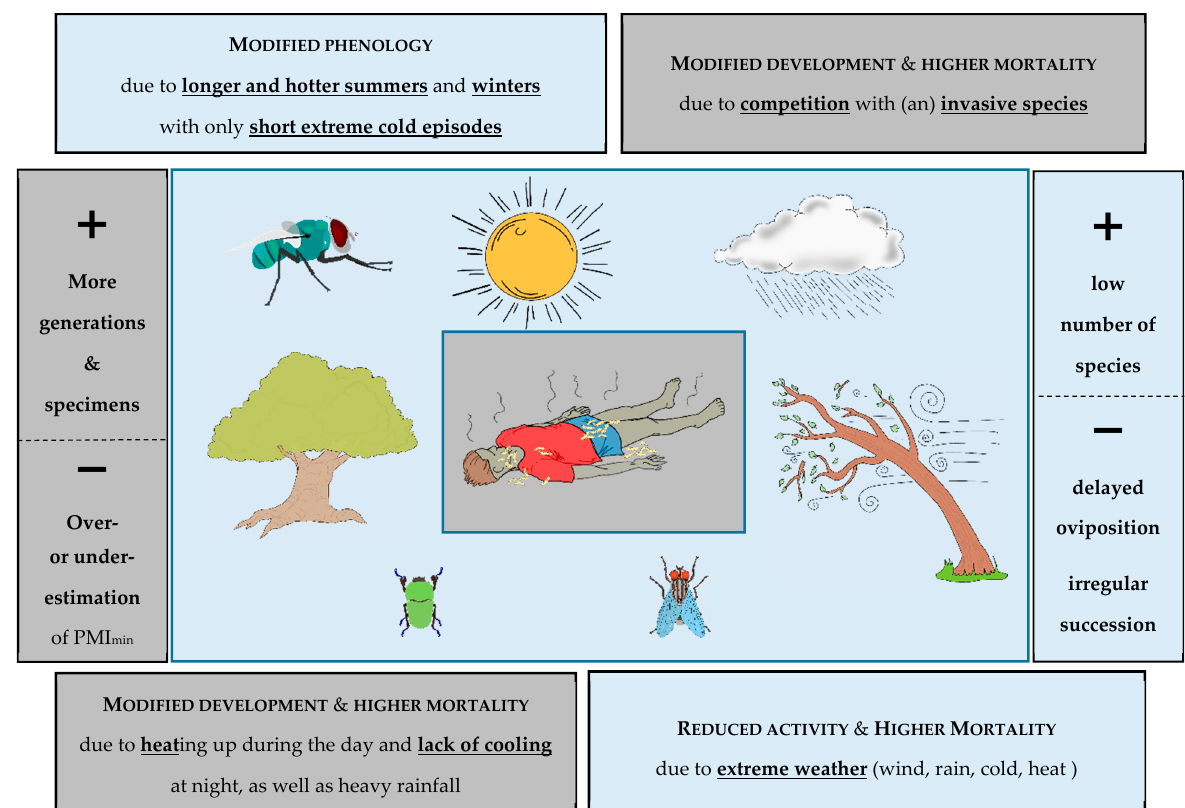
Figure 3. Global warming as a driver of insect decline and its possible impact ( + and − ) on the necrophagous fauna and forensic entomology (grey background: juvenile stages, light blue: adult stages).